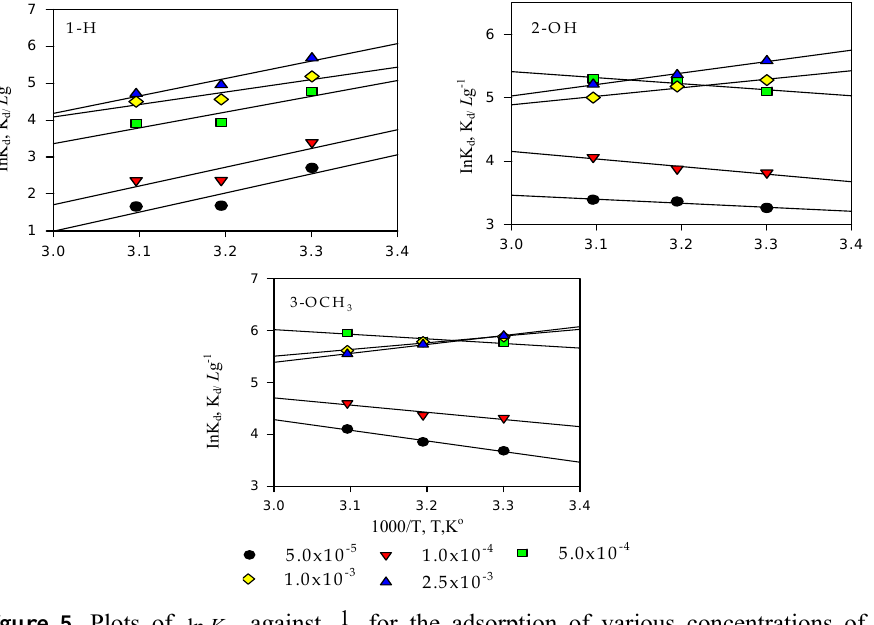
Figure 5. Plots of studied organic cations onto Dowex 50WEX/H + .